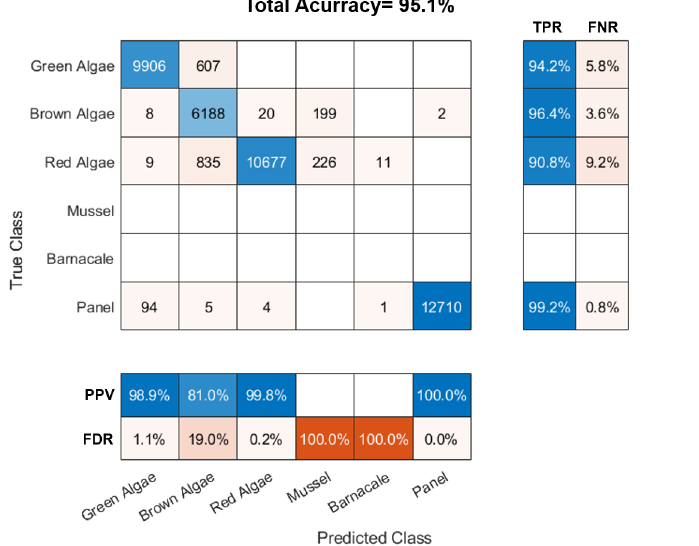
Figure 10. Error matrix for the WNN classification of the model target with ground truth in rows and predictions in columns. The true positive rate (TPR), or recall, and false negative rate (FNR) for each class are presented on the side; the positive predictive value (PPV), or precision, and false discovery rate (FDR) are presented below. No mussels or barnacles were present in the model